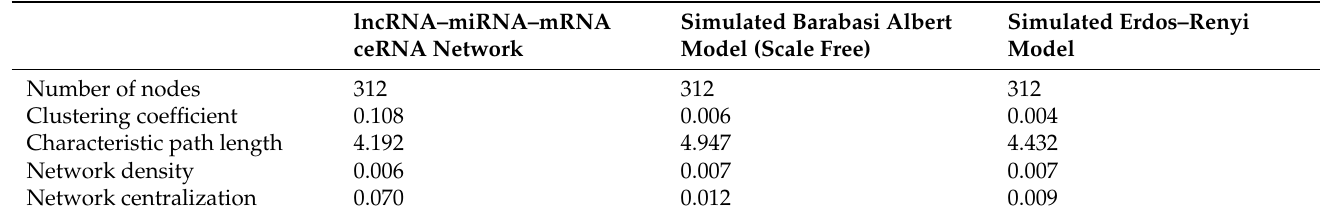
Table 1. Basic network statistics of the two generated networks, compared with simulated random- ized model